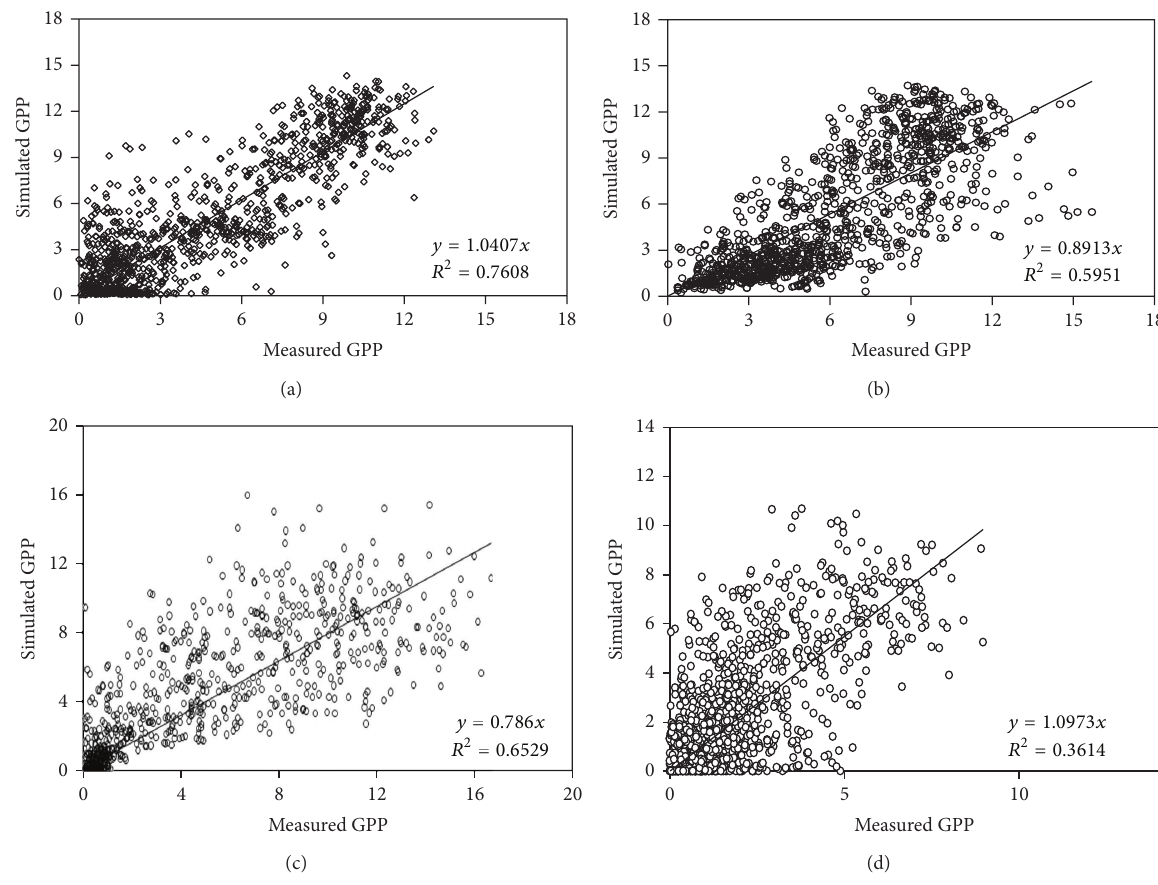
Figure 1: Evaluation of DLEM-simulated GPP against eddy covariance measured daily GPP (gC/m 2 /day) at sites: (a) Duke Forest Hardwoods (US-DK2, NC, USA, deciduous broadleaf forest) from 2003 to 2005; (b) Duke Forest Loblolly Pine (US-DK3, evergreen needleleaf forest) from 2003 to 2005; (c) Shidler Tallgrass Prairie (US-shd, OK, USA, C4 grassland) from 1998 to 1999; (d) ARM SGP Main (US-arm, OK, USA, cropland) from 2003 to